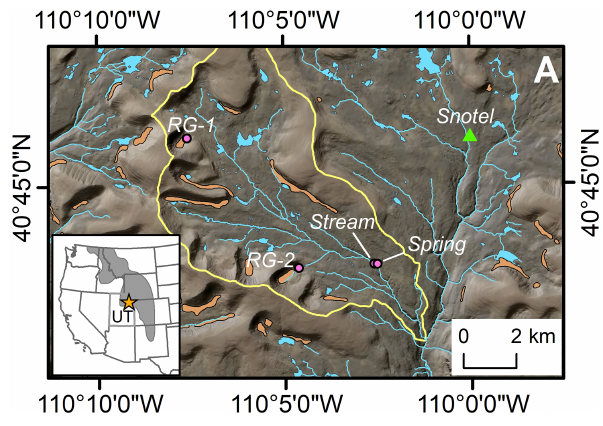
Figure 1. Location map of the study area. Inset shows location of the Uinta Mountains (orange star) within the state of Utah (UT). Shaded gray polygon represents the Rocky Mountains. Map presents the upper Whiterocks River watershed (yellow boundary), mapped rock glaciers (orange), the locations of the RG-1, RG-2, Stream, and Spring water samplers (pink circles), and the Chepeta SNOTEL site (green triangle). Background image from